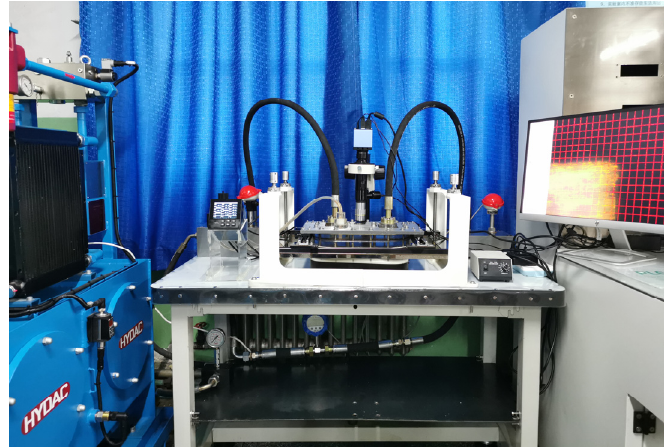
Figure 5. Platform used in experiment for valve orifice temperature measurement.